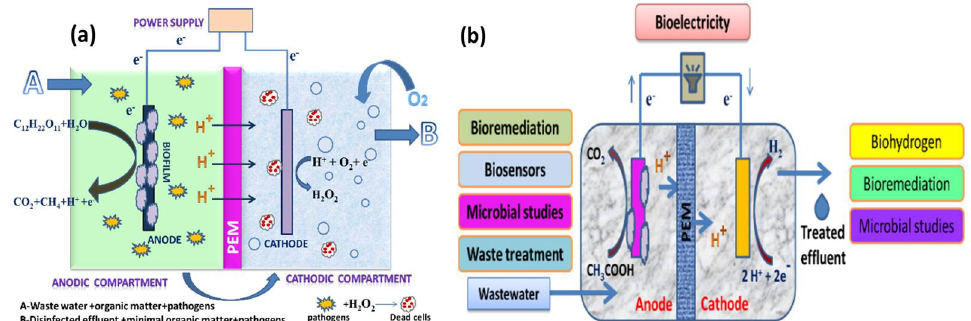
Figure 1. ( a ) Anodic effluent containing residual organic matter and pathogens recalculated into the cathodic chamber for disinfection through H 2 O 2 and ( b ) various important applications of MECs. Meanwhile, CO 2 will react with electrons and protons to produce methane and